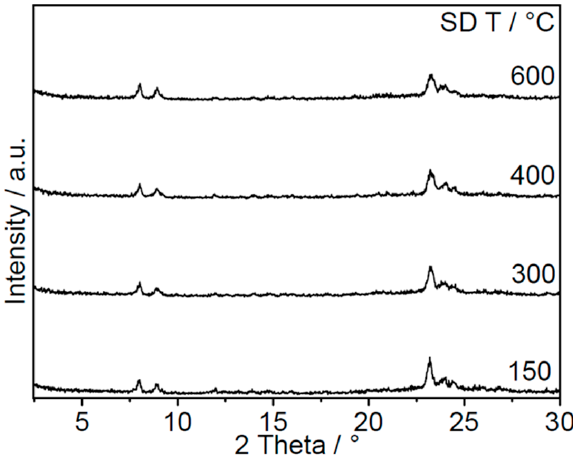
Figure 5. XRD patterns of the solid phase collected after spray drying the suspension of nanosized zeolites at different temperatures. Spray drying temperatures below 400 °C preserve the MFI structure. SD T stands for spray drying temperature.